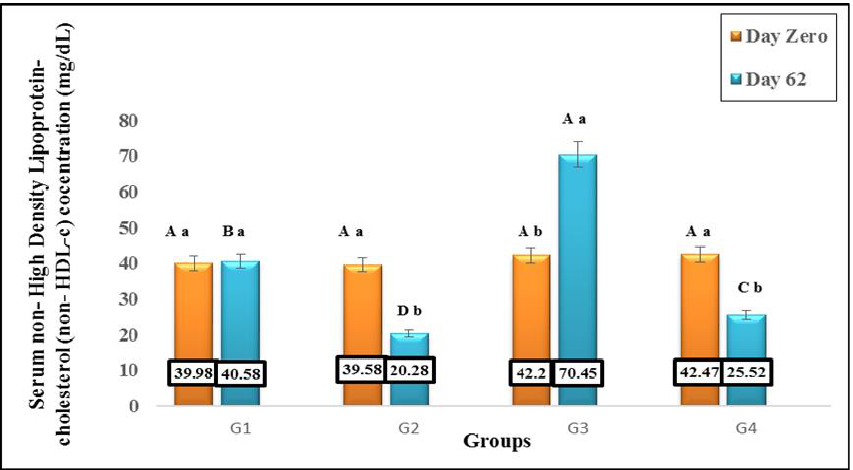
Figure 5. Effect of phosphatidylcholine, fructose and/or combination on serum non-high density lipoprotein-cholesterol (non-HDL-c) concentration (mg/dL). Mean ± SE, n = 9 in a group. G1 control groups (C), G2: (Pc), G3: (Fr), G4: (Fr + Pc). A-C Significant variations P ≤0.05 between